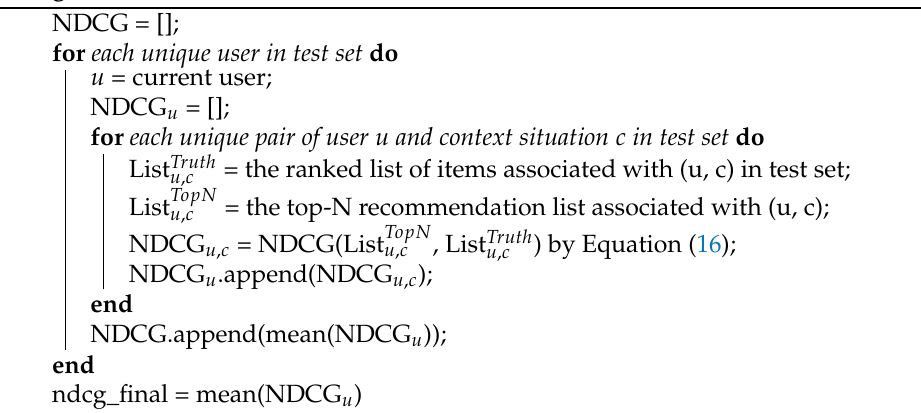
Algorithm 1: Calculation of NDCG in